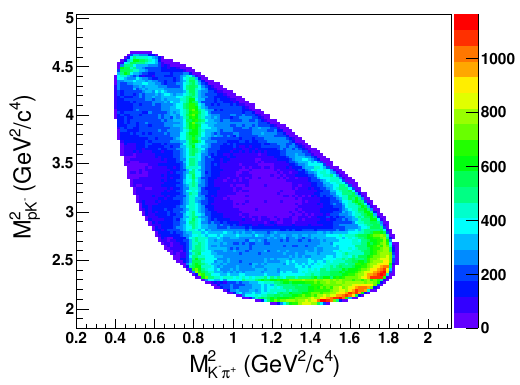
Figure 3 . Dalitz plot of the selected Λ +